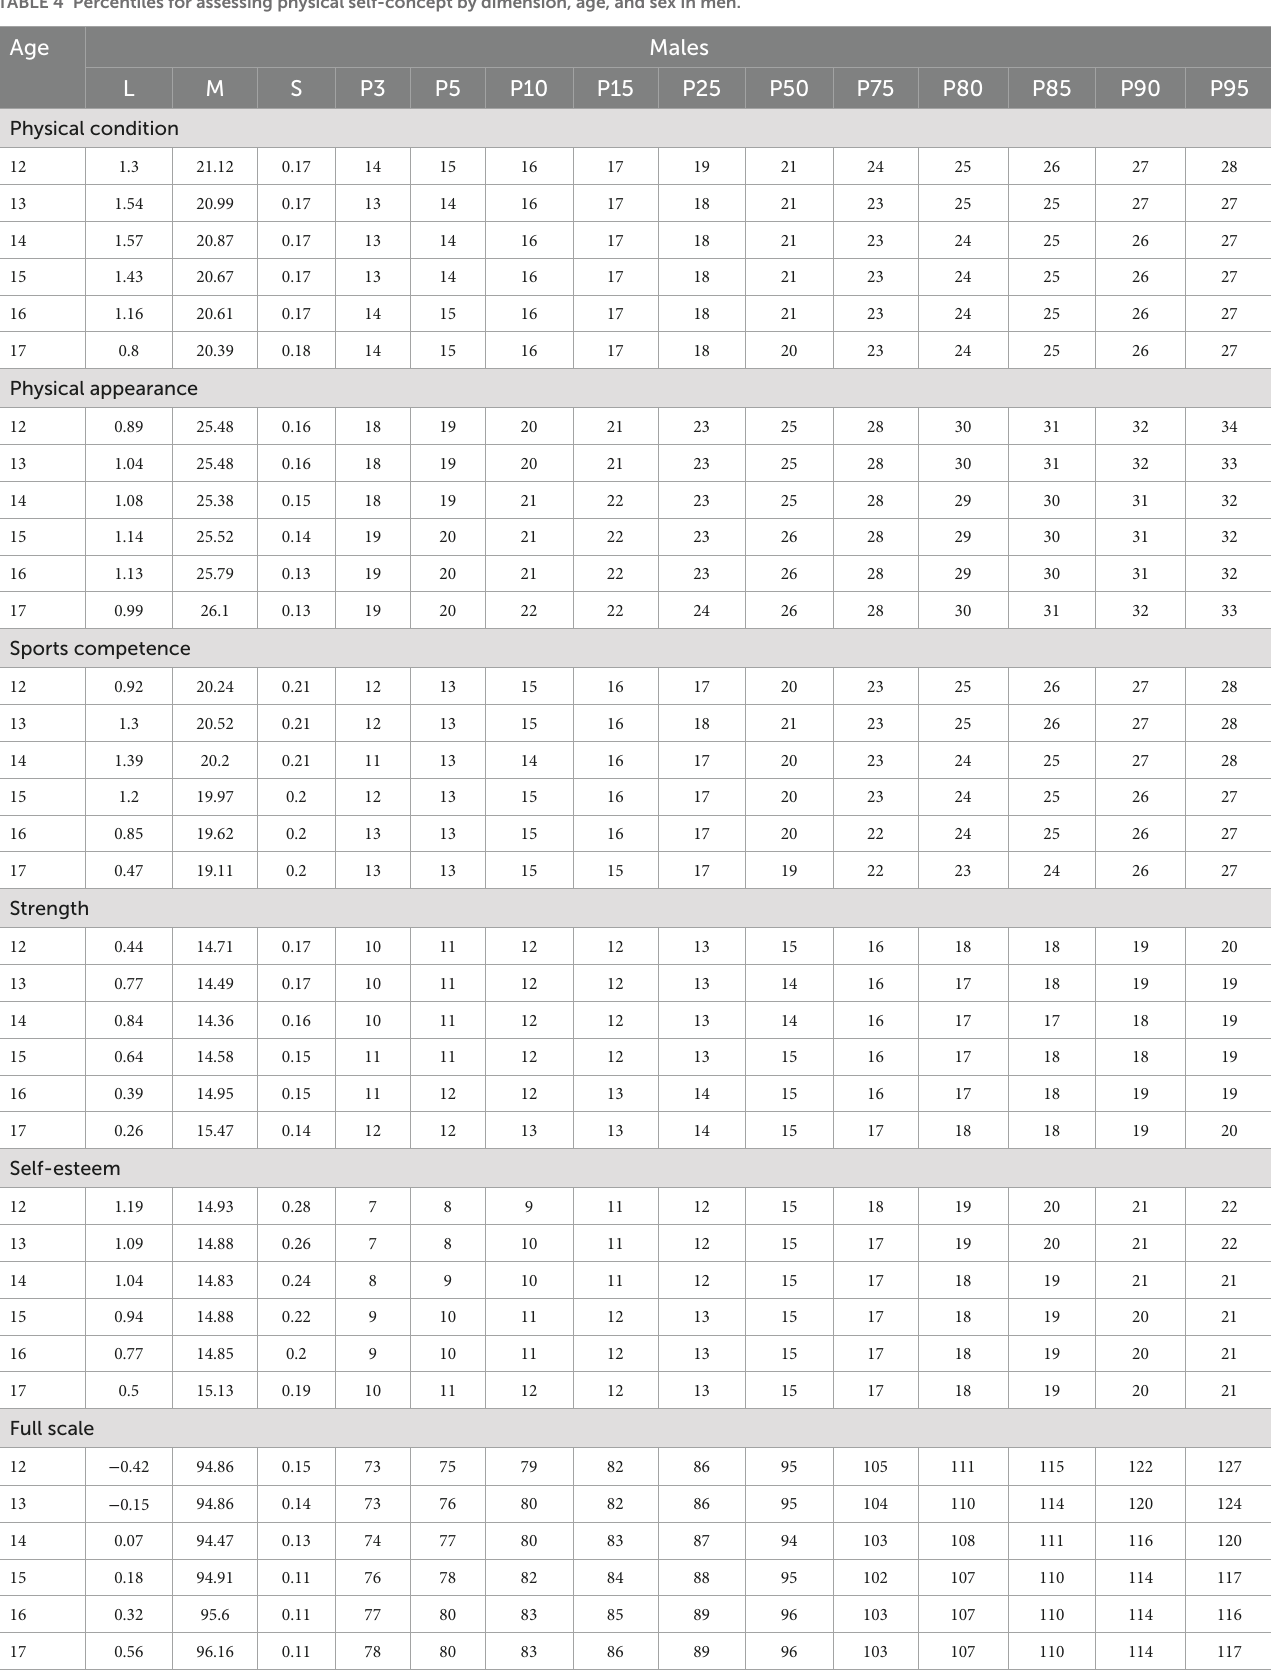
TABLE 4 Percentiles for assessing physical self-concept by dimension, age, and sex in men. Age